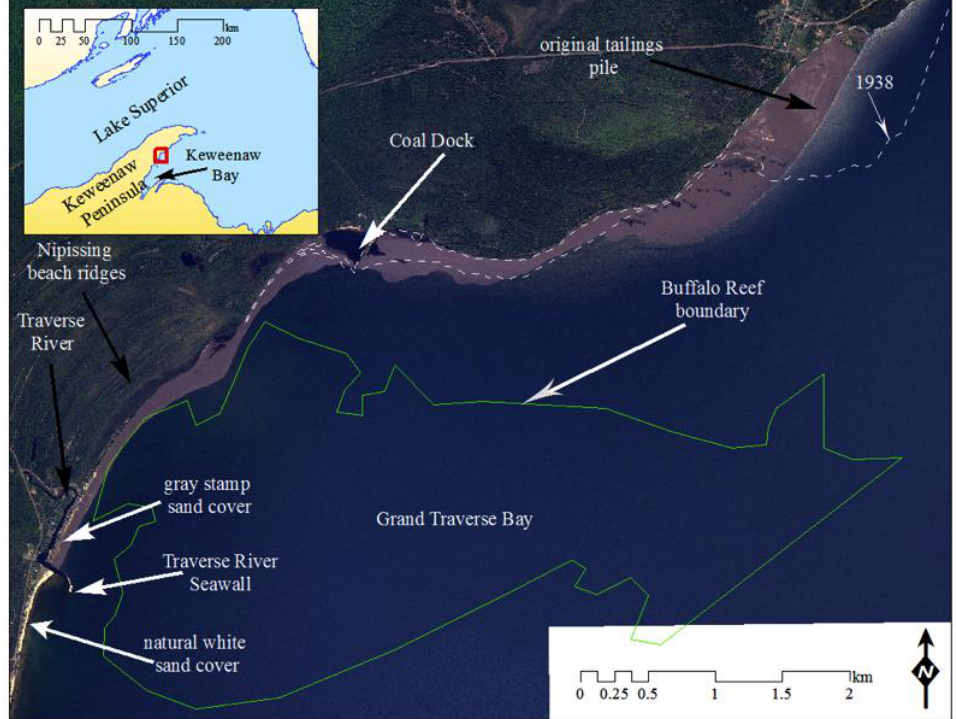
Figure 3. Geographic location of Grand (Big) Traverse Bay on the Keweenaw Peninsula jutting into Lake Superior. Landmarks include the position of the original tailing pile off Gay (the dashed boundary shows the 1938 extent), the Coal Dock, the Traverse River Seawall and the narrow natural white sand beach. The white dashed line outlines the 1938 boundaries of the stamp sand. The boundary of Buffalo Reef is superimposed over offshore waters. Before mining, erosion dominated along the northeastern coastal shelf region, whereas historical deposition dominated the southwestern shoreline (Nipissing beach ridges, natural white beach). Modern-day currents are predominantly